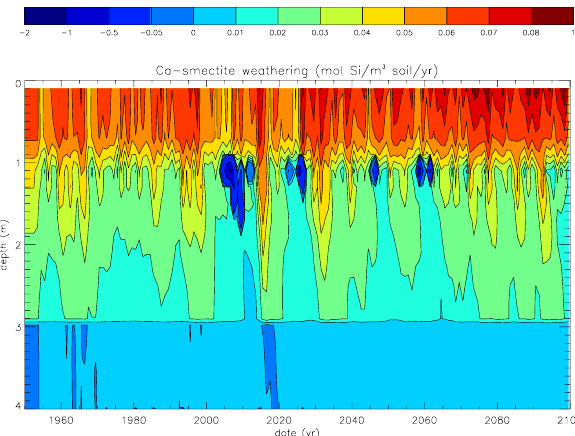
Fig. 5. Calculated smectite dissolution rates plotted as a function of depth and time for the northern